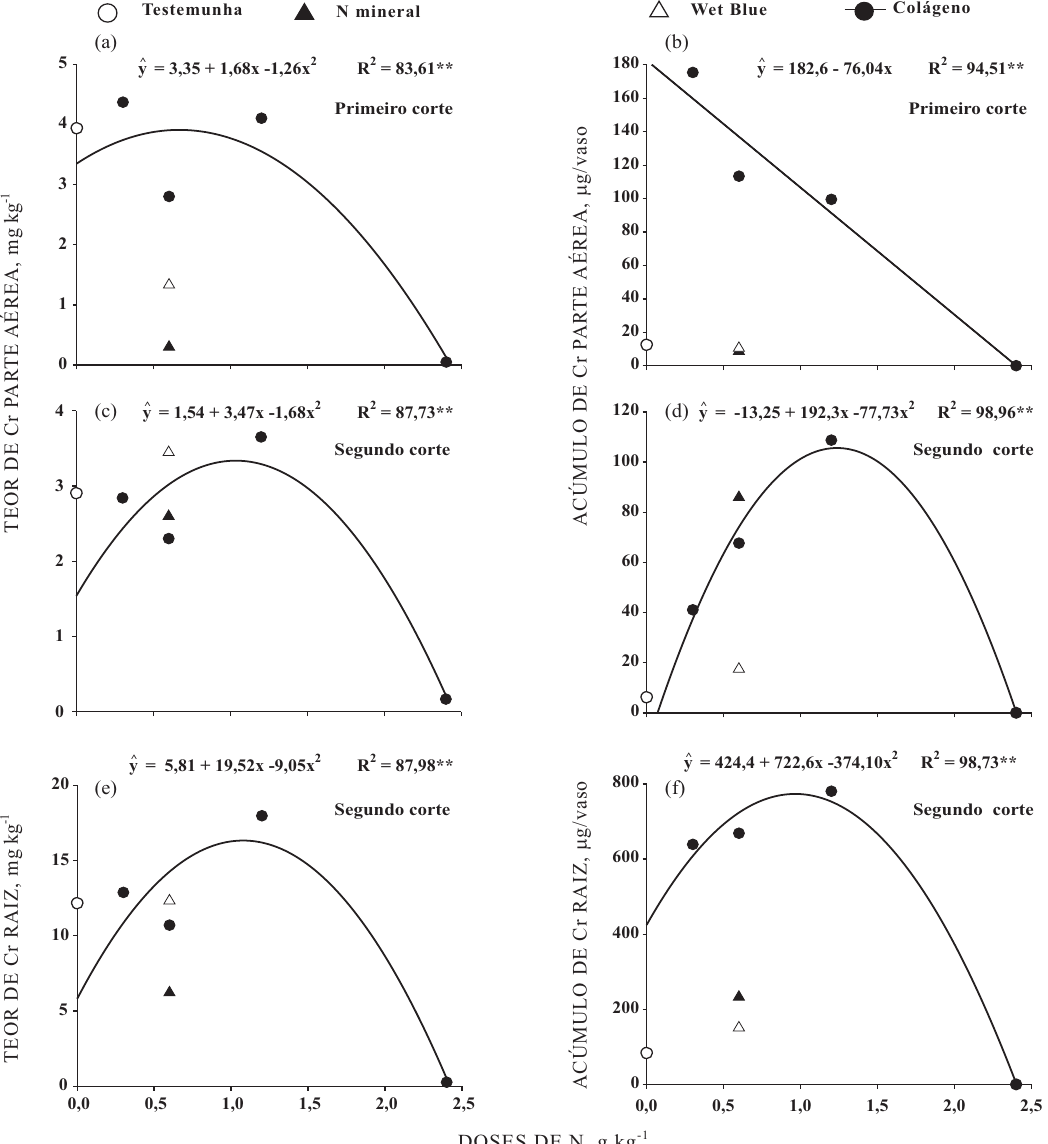
Figura 5. Teores e acúmulos de Cr na matéria seca da parte aérea por ocasião do primeiro (a, b) e segundo (c, d) cortes e de raiz (e,f) respectivamente, em plantas de capim-elefante, com doses crescentes de colágeno e três tratamentos